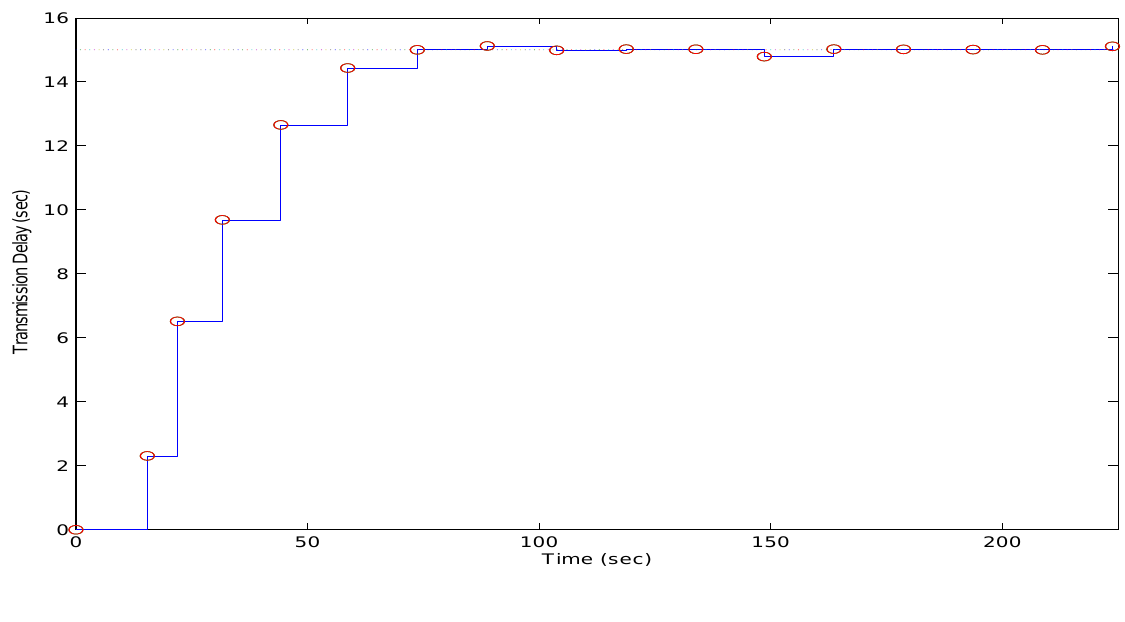
Figure 19 . Measured Time Delay for transmitting an image frame over experimental time, under 10% congestion and packet losses (Initial values R = 0 : 8 , T d = 15 s, and (cid:22) = 0 : 01 ).